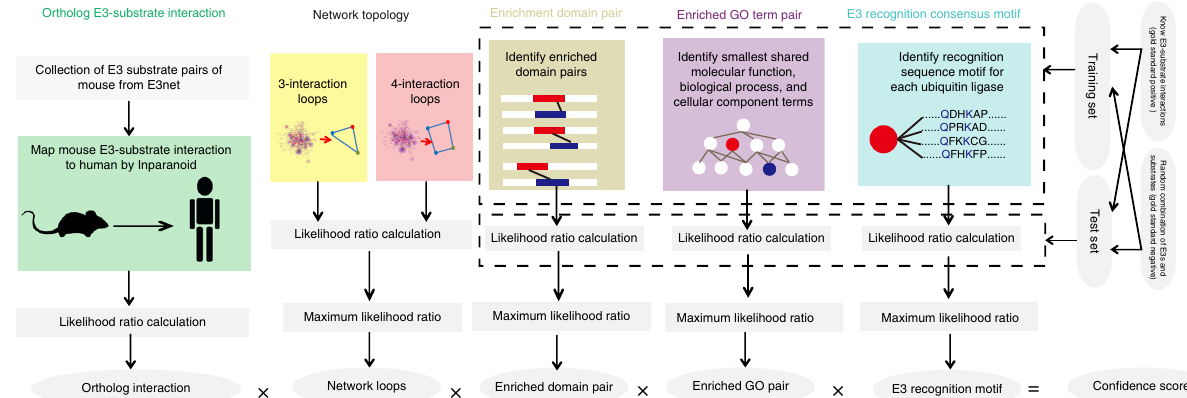
Fig. 1 Data fl ow to predict the human E3-substrate interaction based on naïve Bayesian classi fi cation. Five types of evidence were labeled on the top of each data source. First, likelihood ratios were calculated as the weight for the source(s) of each type of biological evidence towards the prediction of ESI. Second, if there was more than one source for each type of biological evidence, the maximum LR from this data source was identi fi ed. Finally, the likelihood ratio from individual evidence was integrated into a composite likelihood ratio by the naïve Bayesian classi fi